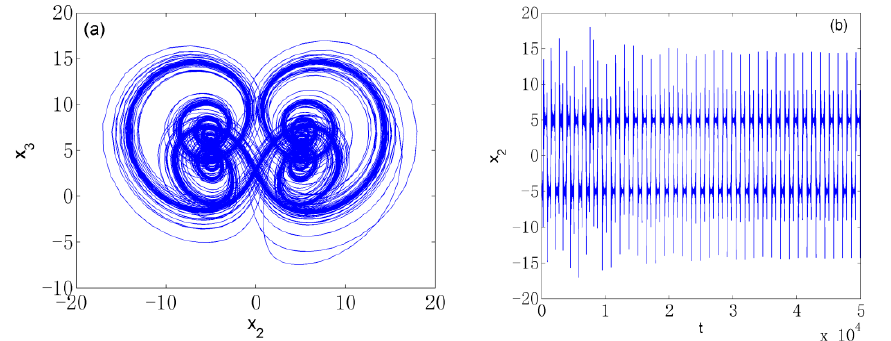
Figure 1. Hyperchaotic attractor of system (2) when c = − 6. ( a ) Phase portrait; ( b ) time evolution curve.